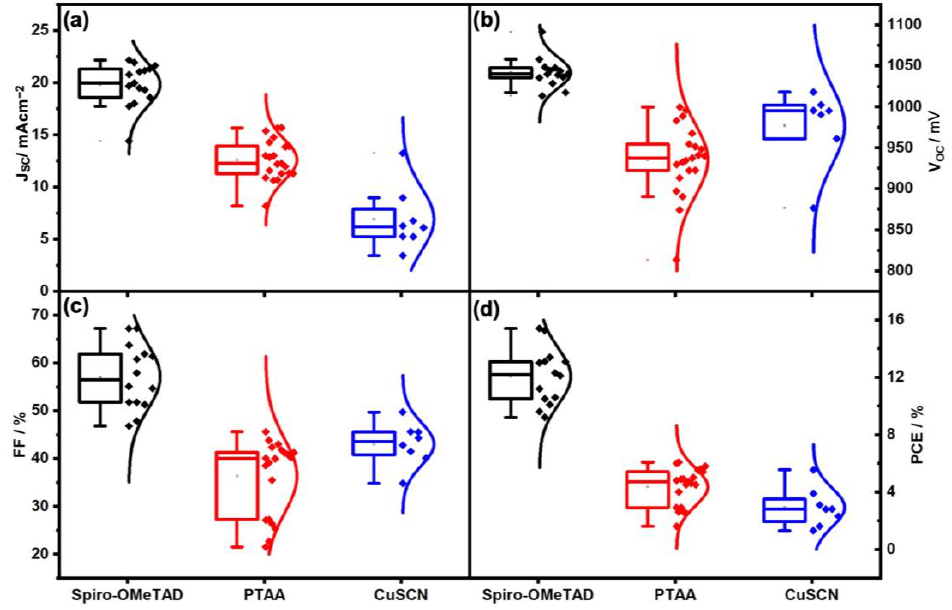
Figure 7. Statistics of J SC ( a ), V OC ( b ), FF ( c ), and PCE ( d ) related to carbon-based solar cells with different HTMs and densification layers, including Spiro-OMeTAD, PTAA, and CuSCN.